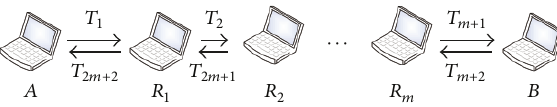
Figure 1: Illustration of signal transmission in one